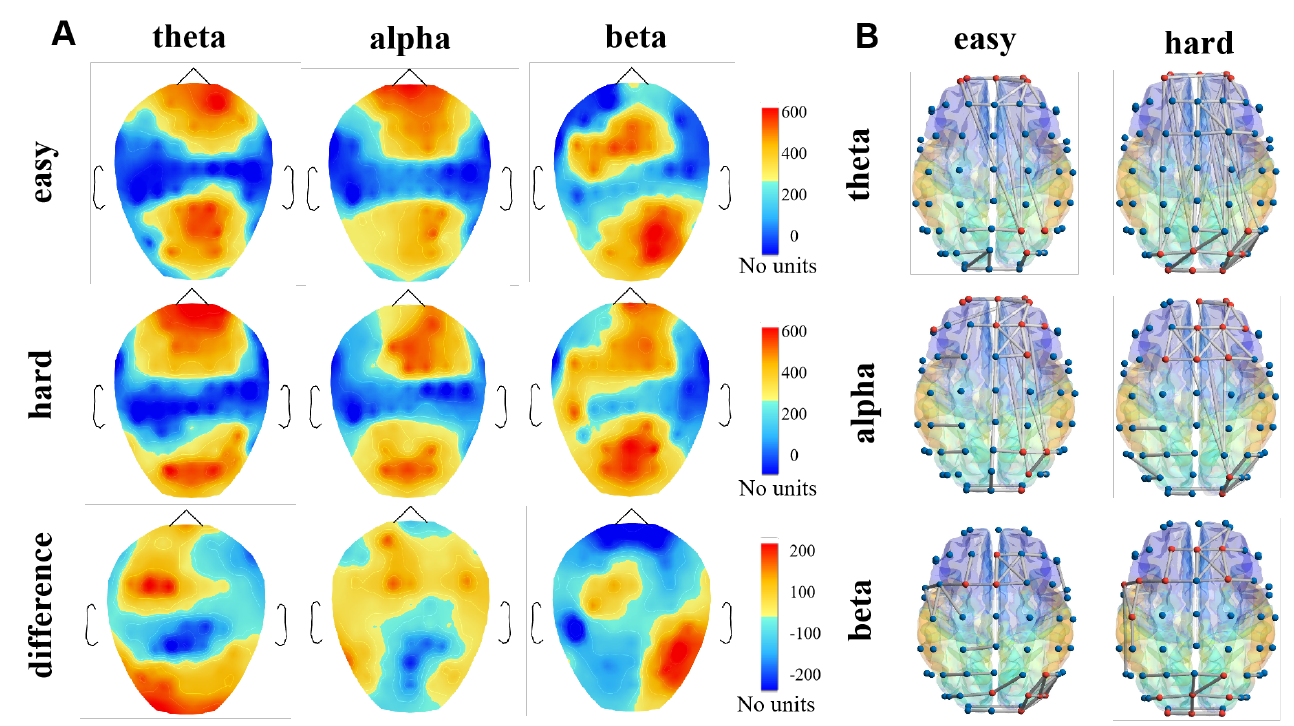
Figure 5. The topography diagram of the node importance distribution. The diagram of three bands is drawn according to the result of the K-order propagation number algorithm. ( A ) Brain topography of node importance distribution. ( B ) The brain network topology diagram. The value of the node importance is mapped from 0 to 1, the node with the importance exceed 0.8 is marked as